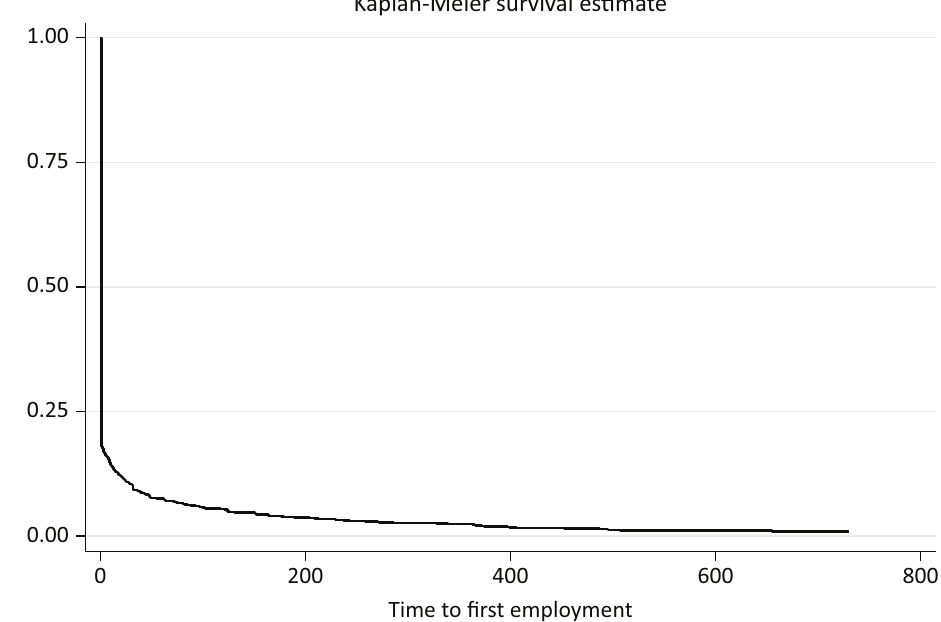
Figure 1. Time to first employment after completing training. Source: Own calculations based on the Jugalo Study (Dietrich,